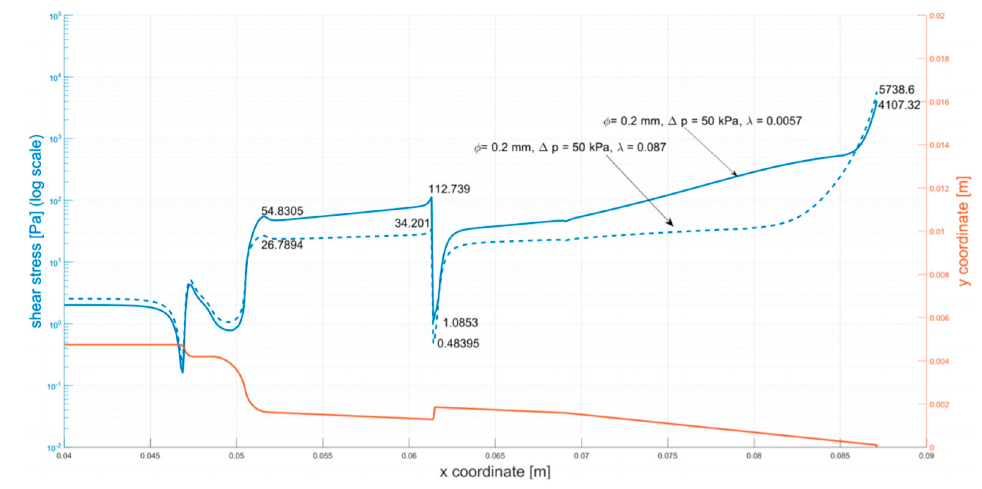
Figure A2. Shear stress at the walls of the cartridge ( φ = 0.2 mm, ∆ p = 50 kPa).